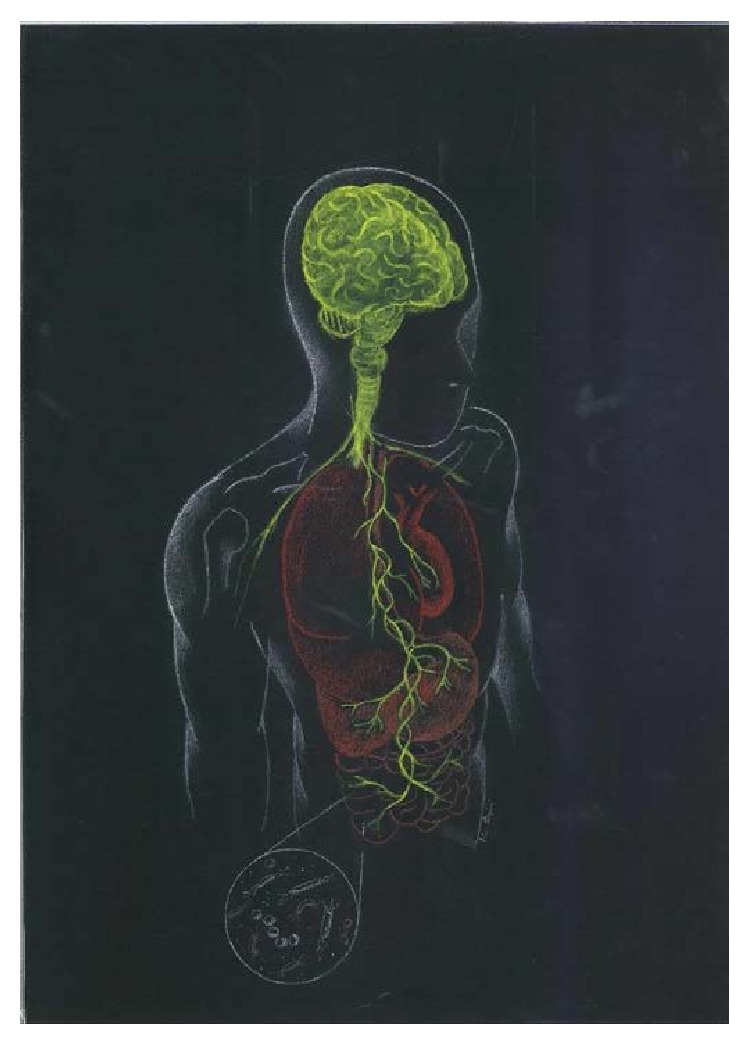
Gut-microbiota axis.